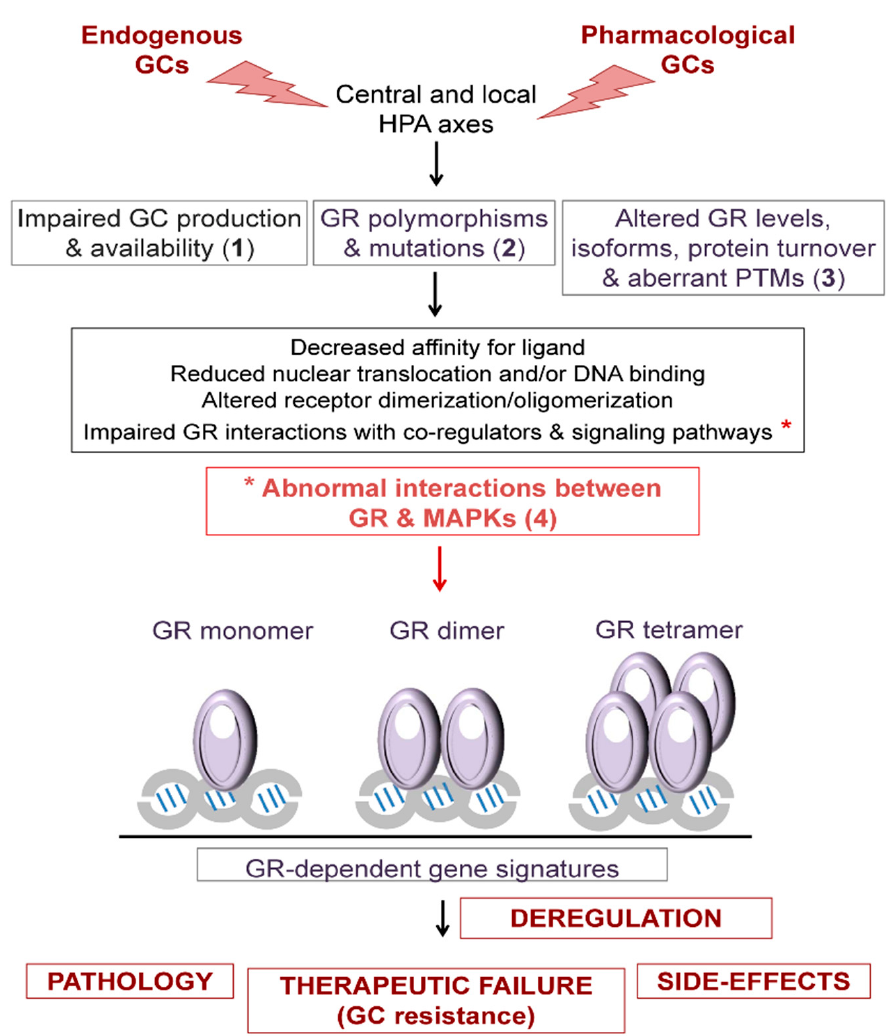
Figure 3. Mechanisms underlying GC sensitivity. Variations in the sensitivity to GCs can affect susceptibility to disease (endogenous) and to the capacity to respond to pharmacological doses of steroid analogs (exogenous). Impairments in either de novo production by the central and local hypothalamic-pituitary-adrenal (HPA) axes or in conversion from inactive to active GCs (availability) affect endogenous response and may lead to disease (1). GR polymorphisms and/or mutations (2), GR expression levels, protein stability, ratios of isoforms, and aberrant post-translational modifi- cations (PTMs) (3) can reduce nuclear translocation and/or DNA binding, alter receptor dimeriza- tion/oligomerization, and affect GR interactions with co-regulators and signaling pathways. Among the abnormal interactions, those between GR and MAPKs can result in pathological changes to the GC response. Overall, defects in the mechanisms that influence GC sensitivity lead to deregulation of the GR-dependent transcriptional